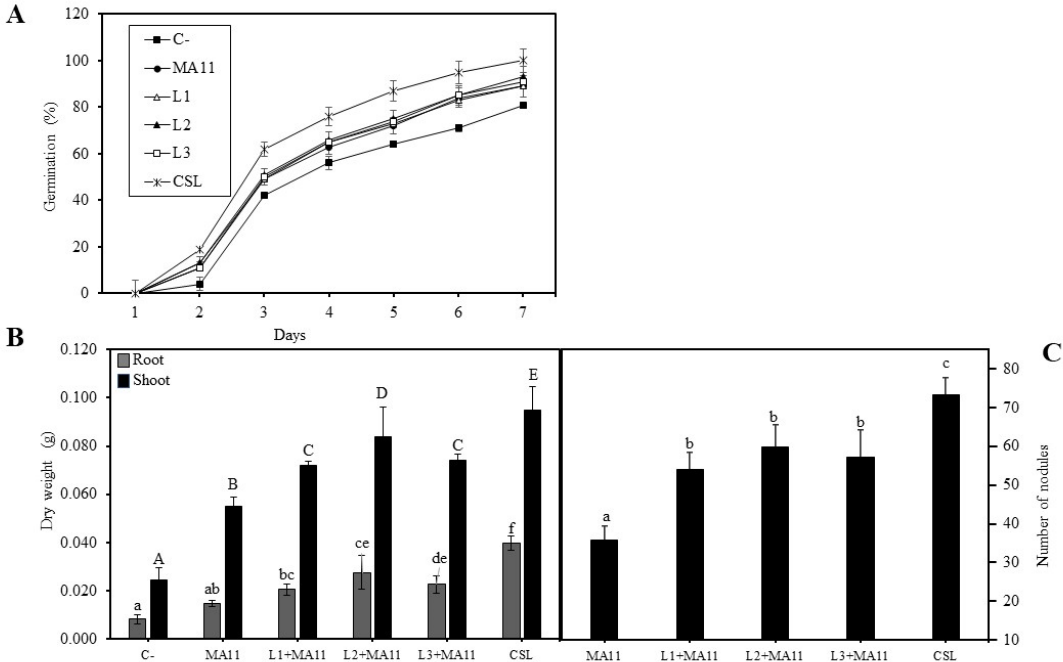
Figure 2. In vitro effects of selected PGPR in M. sativa . ( A ) Number of germinated seeds in 7 days with different inoculums. Values are mean ± S.D. ( n = 50). ( B ) Dry weight of shoots and roots of M. sativa plants after 30 days in BNM plates. Values are mean ± S.D. ( n = 5). Different letters indicate means that are significantly different from each other. Lowercase and uppercase letters are used to qualify different variables and are not comparable among them (one-way ANOVA; LSD test, p < 0.001). ( C ) Number of nodules in plants of M. sativa after 30 days in BNM plates with different inoculums. Values are mean ± S.D. ( n = 5). Different letters indicate means that are significantly different from each other (one-way ANOVA; LSD test, p < 0.001). C-: without inoculation; MA11: inoc-